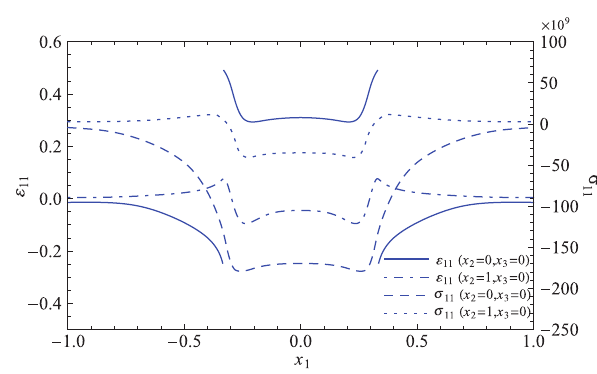
, and stress 11 = 0 ( x -axis) and 2 1